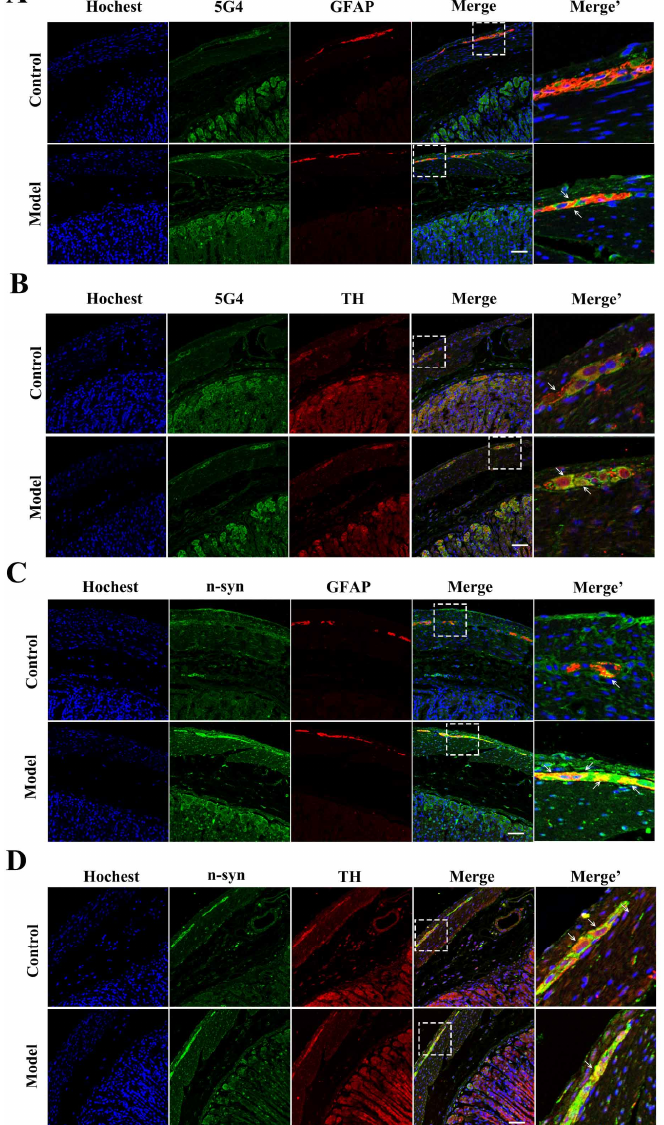
Figure 4. Synucleinopathies mainly existed in the EGCs and TH-positive neurons of the chronic MPTP/p-induced PD mouse gastric myenteric plexus. Oligomeric α-synuclein (detected using the 5G4 antibody) localization in stomach sections from control and model mice, additionally stained for ( A ) GFAP and ( B ) TH (scale bar = 50 μm). Nitrated α-synuclein (detected using the anti-n-syn antibody) localization in stomach sections from control and model mice, additionally stained for ( C ) GFAP and ( D ) TH (scale bar = 50 μm).